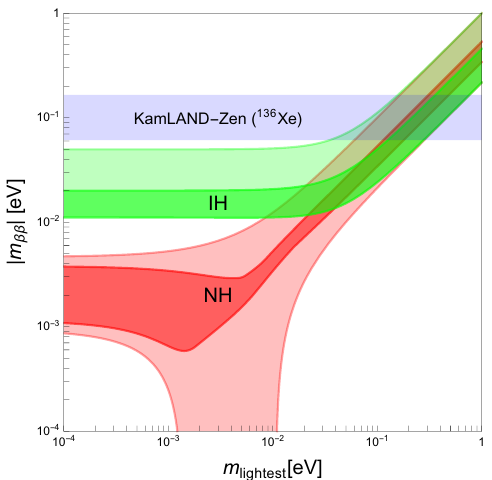
Figure 3 . E(cid:11)ective Majorana neutrino mass parameter j m (cid:12)(cid:12) j as a function of the lightest active neutrino mass m lightest . The light shaded regions indicate the 3 (cid:27) ranges calculated from the oscil- lation parameter uncertainties [47], and the dark shaded areas correspond to the allowed values predicted by the model. The horizontal blue band indicates 90% C.L. upper limits on j m (cid:12)(cid:12) j with 136 Xe from the KamLAND-Zen experiment